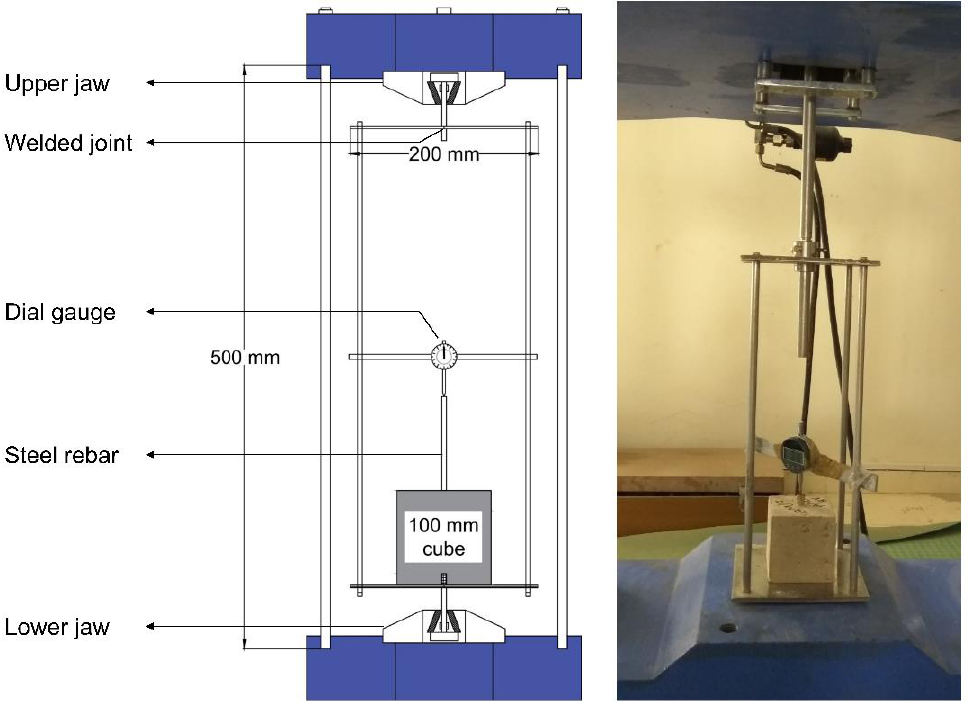
Figure 2. Schematic representation of pull-out test set-up.